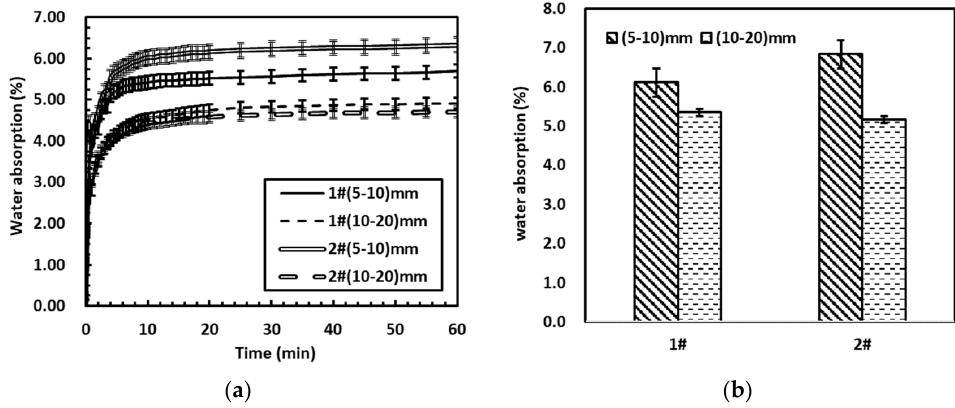
Figure 3. Water absorption of the different origin recycled coarse aggregates, ( a ) 0 min–60 min, ( b ) 24